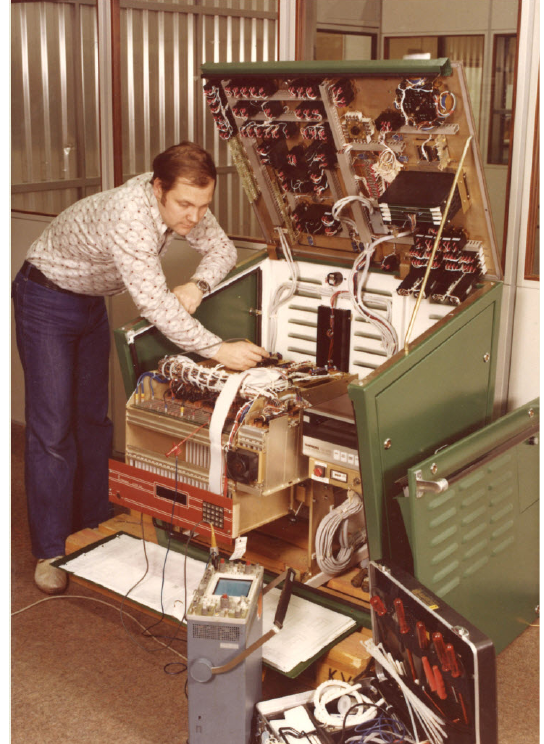
Figure 4: The ADP311 was more compact than the ADP500 series, with all electronics now col- lected in the console. The photo shows Odd Inge Tangen performing troubleshooting on the KS500 computer. Photo: KM.